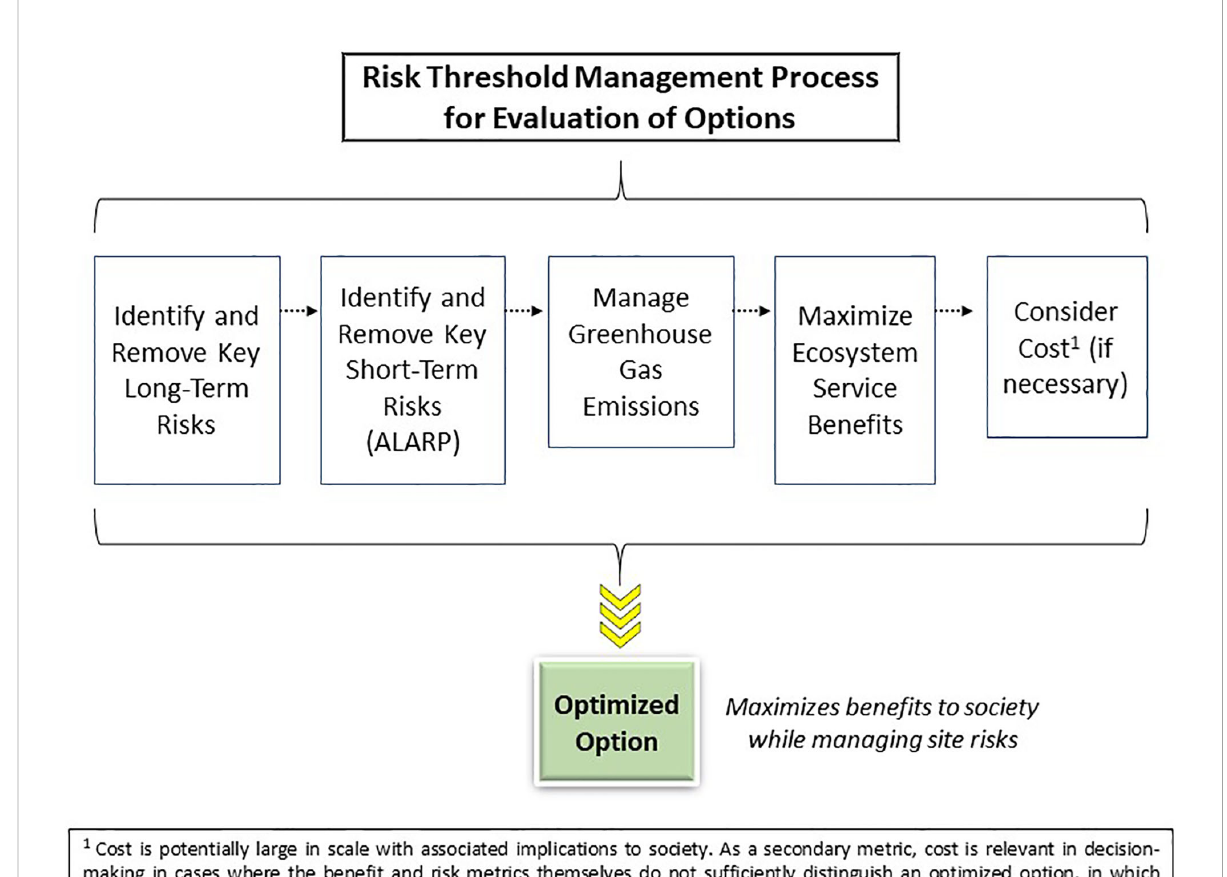
FIGURE 6 A Schematic Representation of the Process for Risk Threshold Management and Option